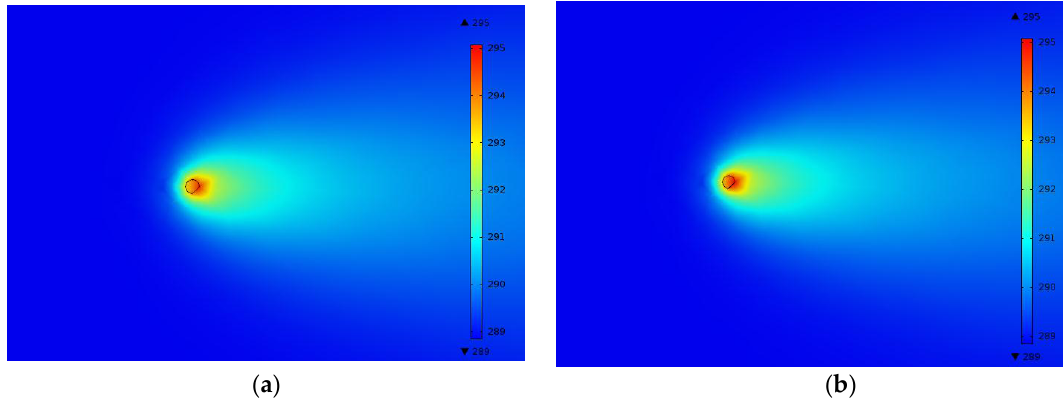
Figure 6. Temperature response after one-month (u = 2.5 × 10 −6 m/s, D/L ratio = 0.00075). ( a ) Borehole permeability same as ground); ( b ) Impermeable borehole. Energies 2016 , 9 , 318